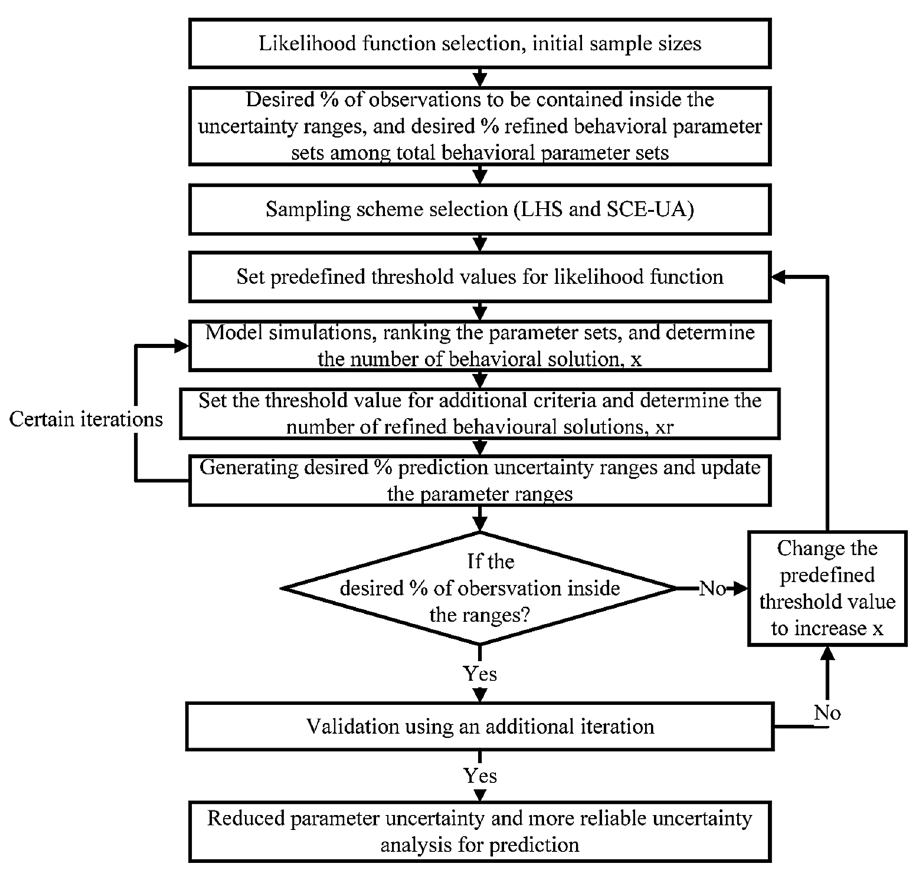
Figure 4. The framework of the MS-CUA method for calibration and